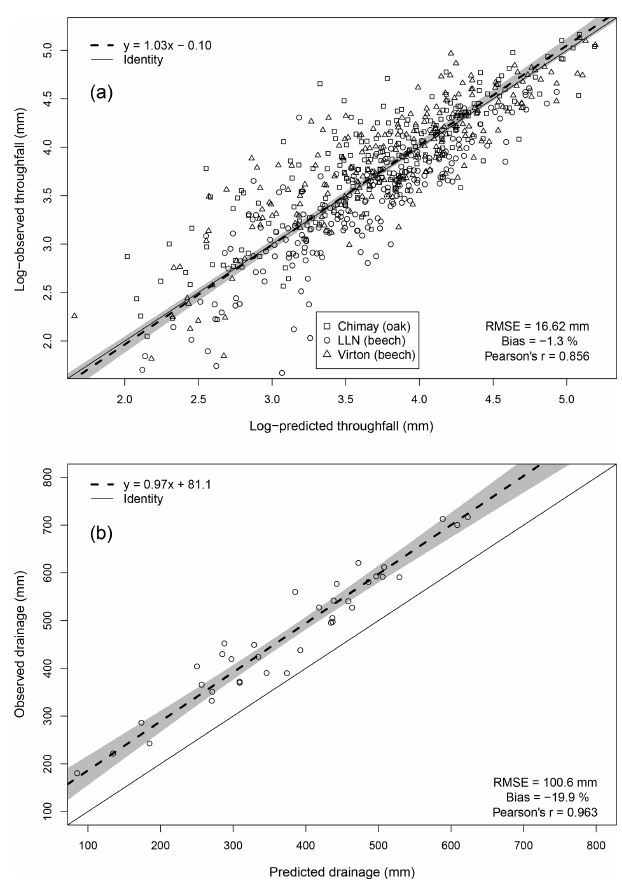
Figure 5. (a) Comparison of the log-transformed observed and predicted monthly throughfall in Chimay (oak), Louvain-la-Neuve (beech) and Virton (beech) between 2000 and 2016 and comparison of observed and (b) predicted annual drainage in all study stands between 2008 and 2016. The quality of the non-transformed pre- dictions is indicated by the RMSE, the relative bias and the Pear- son’s correlation coefficient ( r ). The shaded area represents the con- fidence interval of the Deming regression (95%) of observations on predictions, and the solid line corresponds to the identity